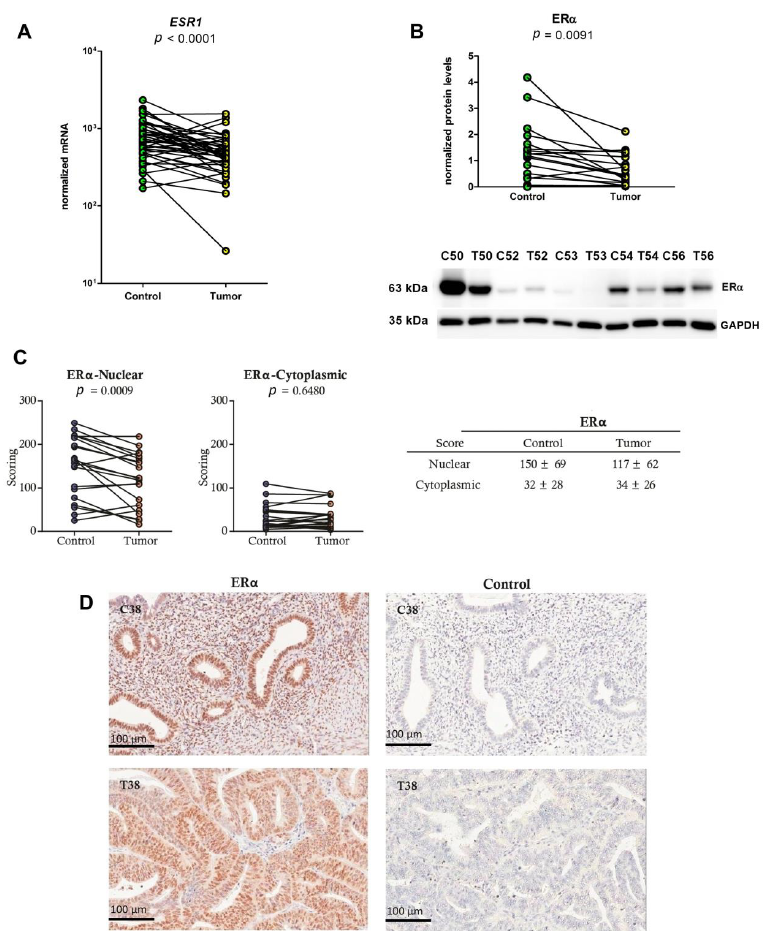
Figure 1. ERα mRNA and protein levels in endometrial cancer and adjacent control endometrium. ( A ) Before-and-after graph shows the normalized expression levels of the ESR1 gene in adjacent endometrial tissue (Control) and the corresponding EC tissue (Tumor). The levels of gene expres- sion are on a logarithmic scale. ( B ) ECL detection of ERα (63 kDa band). 18 paired samples were analyzed using anti- ERα antibodies (SP1, Thermo Fisher Scientific, Cat. #: RM-9101-15, Lot:9101513081A), GAPDH was used as a normalization control. Before-and-after plots show quan- tification of Western blotting data. Below, representative membrane with ERα and GAPDH staining is shown. EC tissue (T), adjacent control endometrial tissue (C). ( C ) IHC scores in 21 samples from adjacent control endometrial tissue (Control) and EC tissue (Tumor). Table shows mean scores ± standard deviations, while before-and-after graphs show nuclear and cytoplasmic ERα stai ning